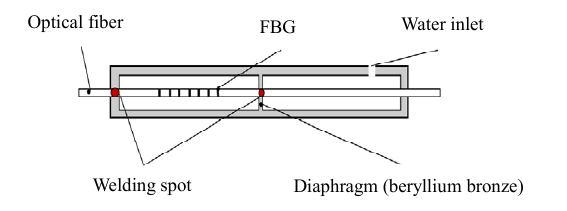
Fig. 2 Sketch of the pressure sensor